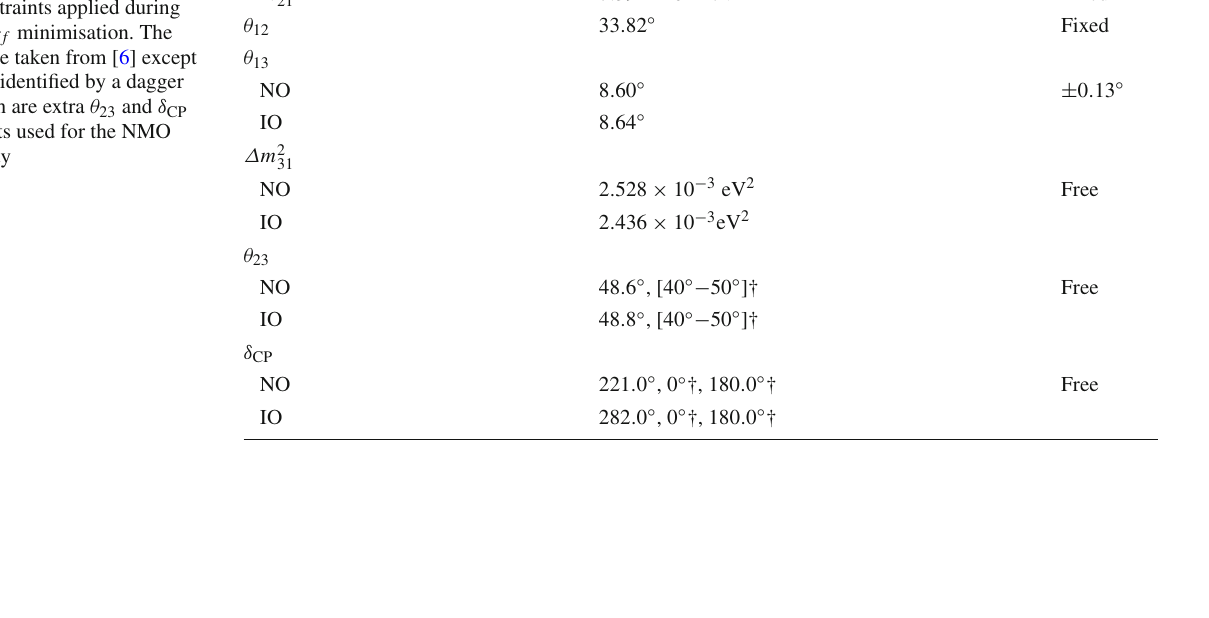
Fig. 8 (Left) Expected event distributions for NO after 3 years of data taking for events classified as track (top), intermediate (middle), and shower (bottom). (right) Signed binned Poisson likelihood χ 2 derived using these distributions and the ones obtained minimising LL eff with the IO hypothesis. If more events are expected for NO than for IO, the value plotted is LL 0 , i which, as defined in Eq. 4, is positive. Otherwise, the value plotted is − LL 0 ,